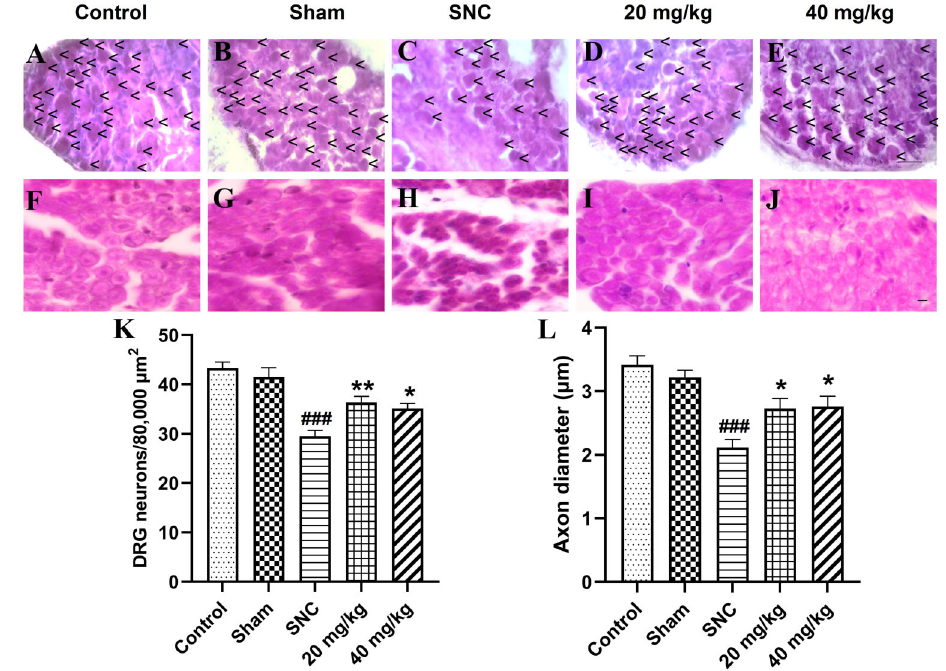
Figure 2. Effects of pinostrobin (PB) treatment (20 and 40 mg/kg) on dorsal root ganglion (DRG) neurons and axon diameters on day 28 after sciatic nerve crush (SNC). A – E , H&E staining of DRG neurons (arrow heads) (scale bar=50 m m) and ( F – J ) histological analysis of axons (scale bar=5 m m). K , Quantitative analyses of number of DRG neurons and ( L ) axon diameter. Data are reported as means ± SE (n=6). *P o 0.05, **P o 0.01 vs SNC group and ### P o 0.001 vs control group